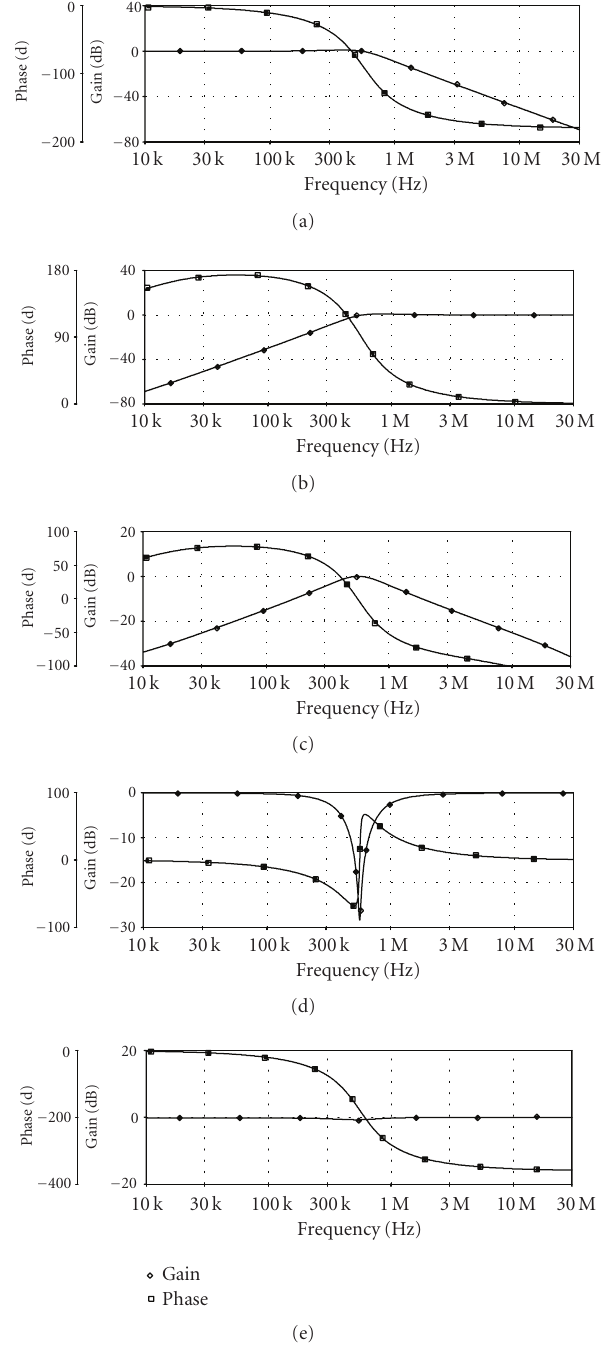
Figure 6: Gain and phase responses of the biquad filter in current- mode for (a) LP, (b) HP, (c) BP, (d) BR, (e) AP.